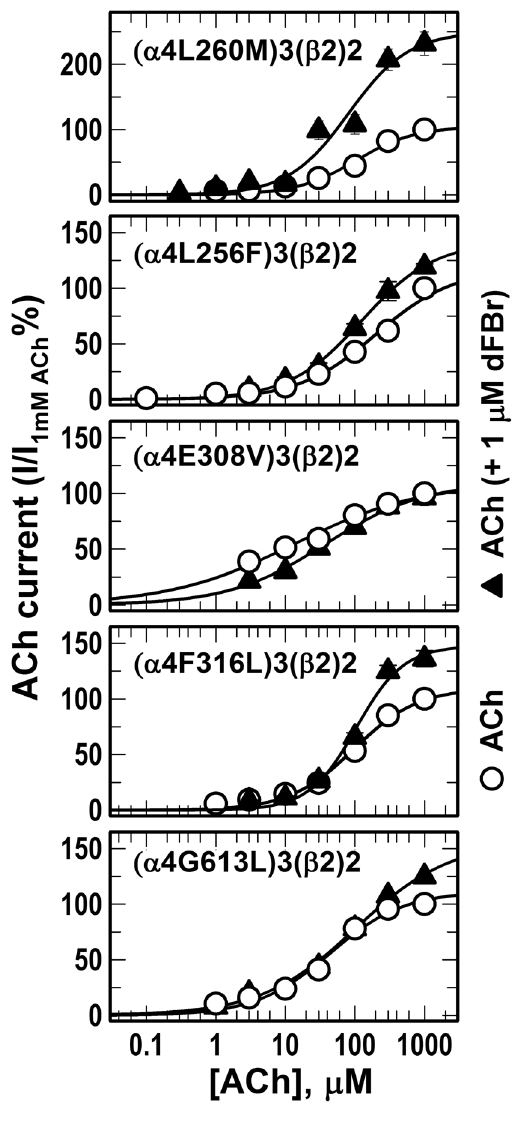
Figure 9. Effect of dFBr on the ACh dose-response curve of mutant α 4 β 2 nAChRs. Currents elicited by Xenopus oocytes expressing mutant ( α 4) 3 ( β 2) 2 nAChRs in response to 10-second applications of increasing concentrations of ACh (alone ( ○ ) or + 1 µ M dFBr ( ▲ )) were recorded and normalized to peak currents elicited by 1 mM ACh alone. Replicas from the same oocyte were averaged and the Average ± SE of at least 3 oocytes were plotted and fit to a single site model using Equation 1. ACh I max in the presence of 1 µ M dFBr calculated from curve fitting for ( α 4C254S)3 ( β 2)2, ( α 4L256F)3 ( β 2)2, ( α 4L260M)3 ( β 2)2, ( α 4E308V)3 ( β 2)2, ( α 4F316L)3 ( β 2)2, ( α 4F606Y)3 ( β 2)2, ( α 4G613L)3( β 2)2 were 190 ± 08, 142 ± 08, 250 ± 36, 110 ± 06, 148 ± 12, 159 ± 07, and 157 ± 19%, and the probability ( P ) that Imax in the presence of 1 µ M dFBr were different from normalized current response to 1 mM ACh alone ( Imax = 100) were < 0.001, 0.057, < 0.001, 0.602, 0.031, 0.001, 0.012,